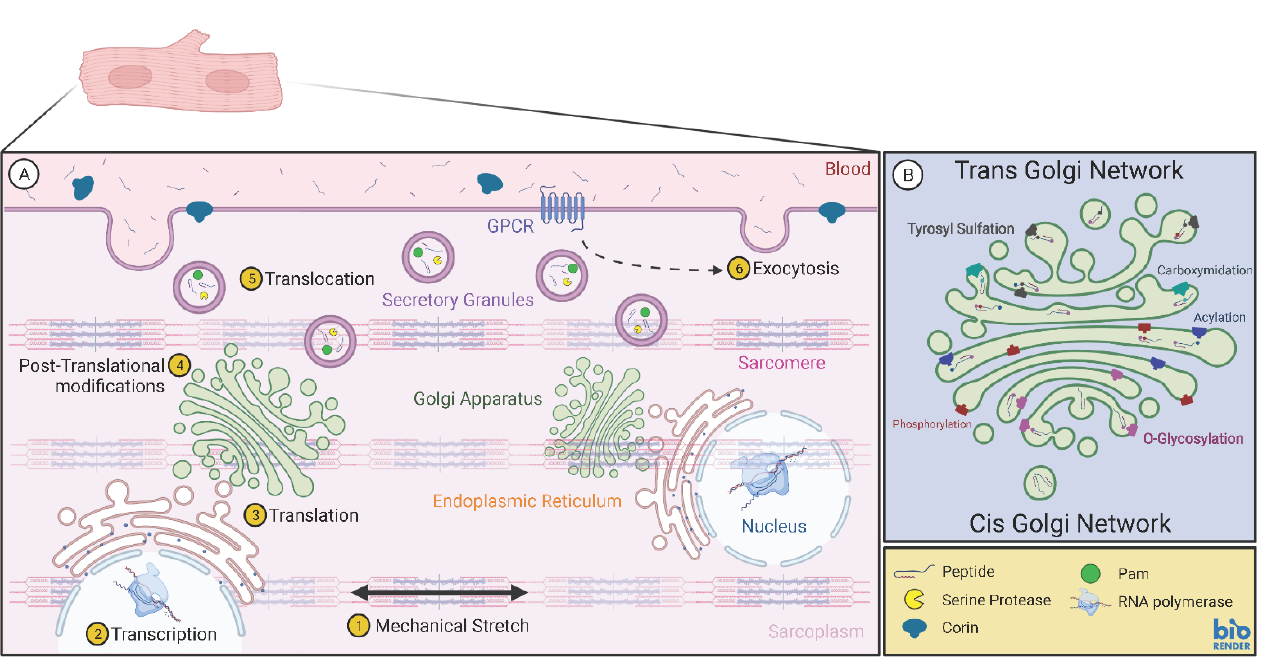
Figure 3. Schematic presentation of a cardiac myocyte containing a regulated secretory pathway ( A ) with its post-translational modification possibilities ( B ) (created in Biorender.com accessed on 17 May 2022).